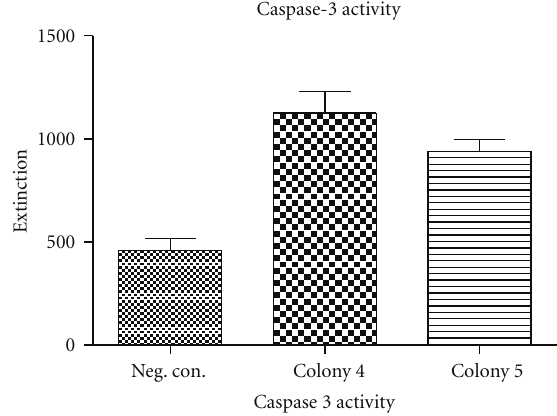
Figure 4: Illustration of expression anticancer activity of trans- formed bacteria on colon cancer cultures. BMP-2 expressing colonies were co-cultured with DLD-1 cells. Caspase-3 activity was measured using a fluorescent detection methodology. Colonies 4 and 5 show a significant higher caspase-3 activity compared to the negative control. Statistical significance was confirmed using a heteroscedastic two-sided Student’s t -test. In this figure the negative control was bacteria containing a LacZ